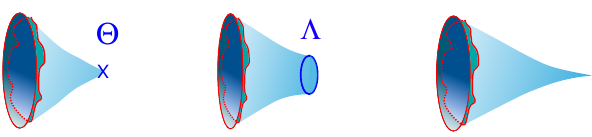
Figure 2 . Geometric interpretation of the different orbits. Left: elliptic orbit with a conical defect. Middle: hyperbolic orbit with a geodesic neck. Right: parabolic orbit with a